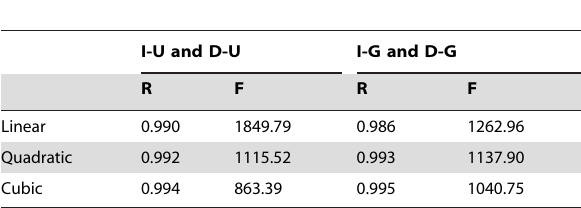
Table 2. The correlation (R) and variance (F) between incidence (I) and death (D) in TB patients in the US (U) and Germany (G) using linear, quadratic, and cubic parametric equations.